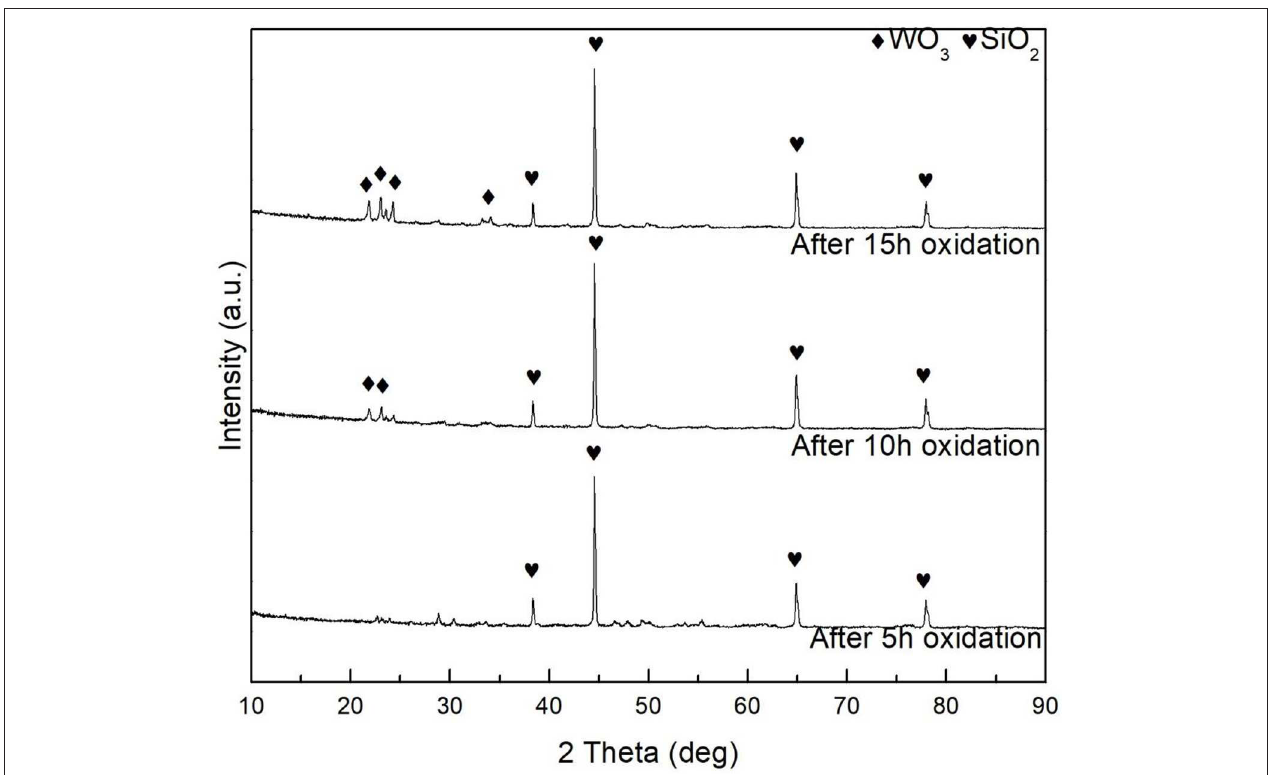
FIGURE 12 | X-ray diffractometer patterns of the samples S4 after cyclic oxidation test.